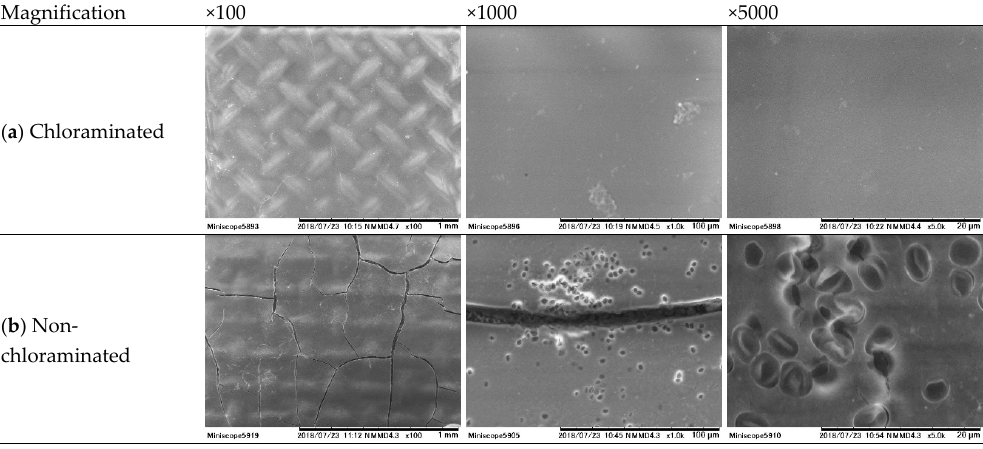
Figure 8. Images of FO membrane surface attained after the first pre-concentration using primary wastewater effluent: ( a ) chloraminated and ( b ) non-chloraminated FO systems.